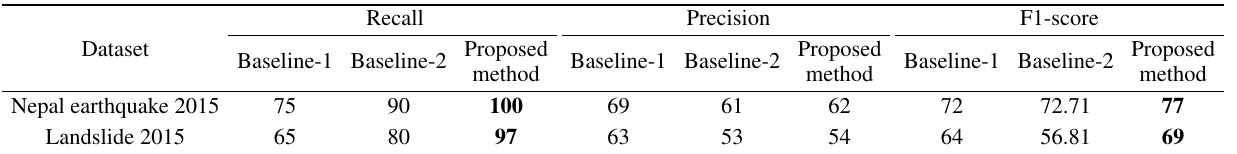
Table 11 Comparison of proposed method with state-of-the-art methods such as baseline-1 [6] and baseline-2 [10] on different disaster